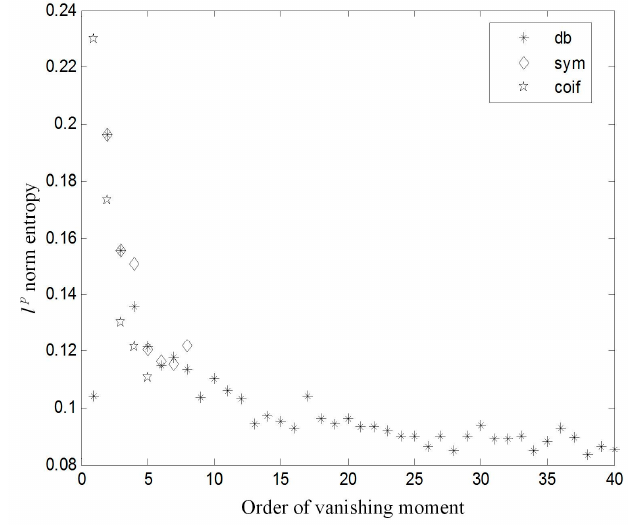
Figure 5. l p norm entropy of the wavelet function of Daubechies wavelet (dbN), Coiflet wavelet (coifN), and Symlets wavelet (symN).